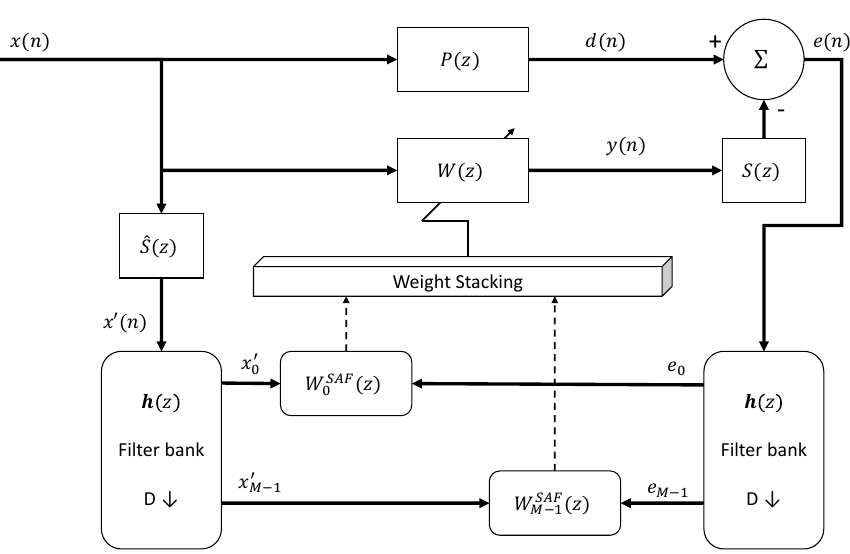
Figure 2. Feedforward delay-less subband Active Noise Cancellation (ANC) system.